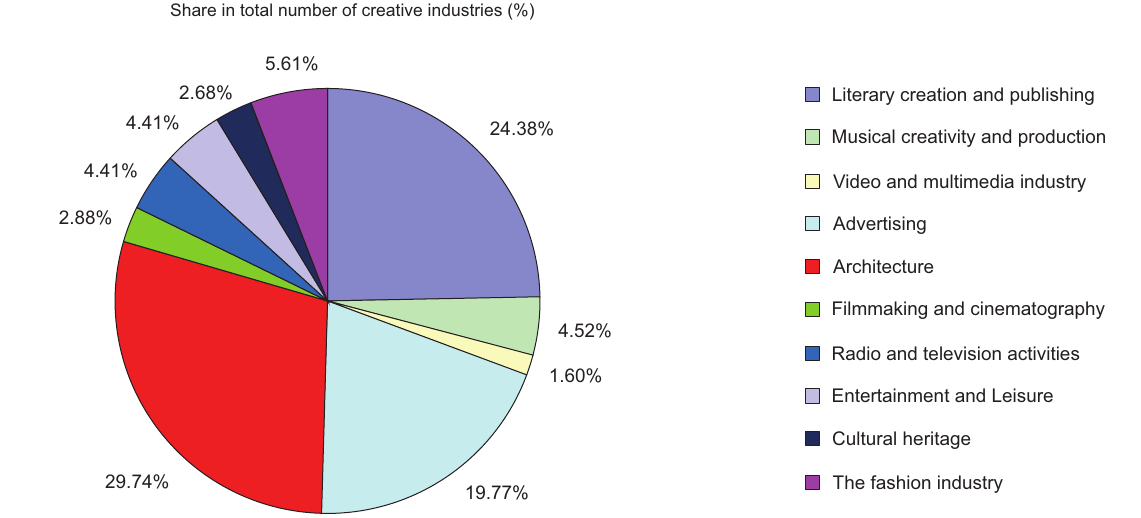
Fig. 2. Share in the total number of creative industries in Bosnia and Herzegovina, 2011. Source: adapted from the Centre for Policy and Governance, 2013.